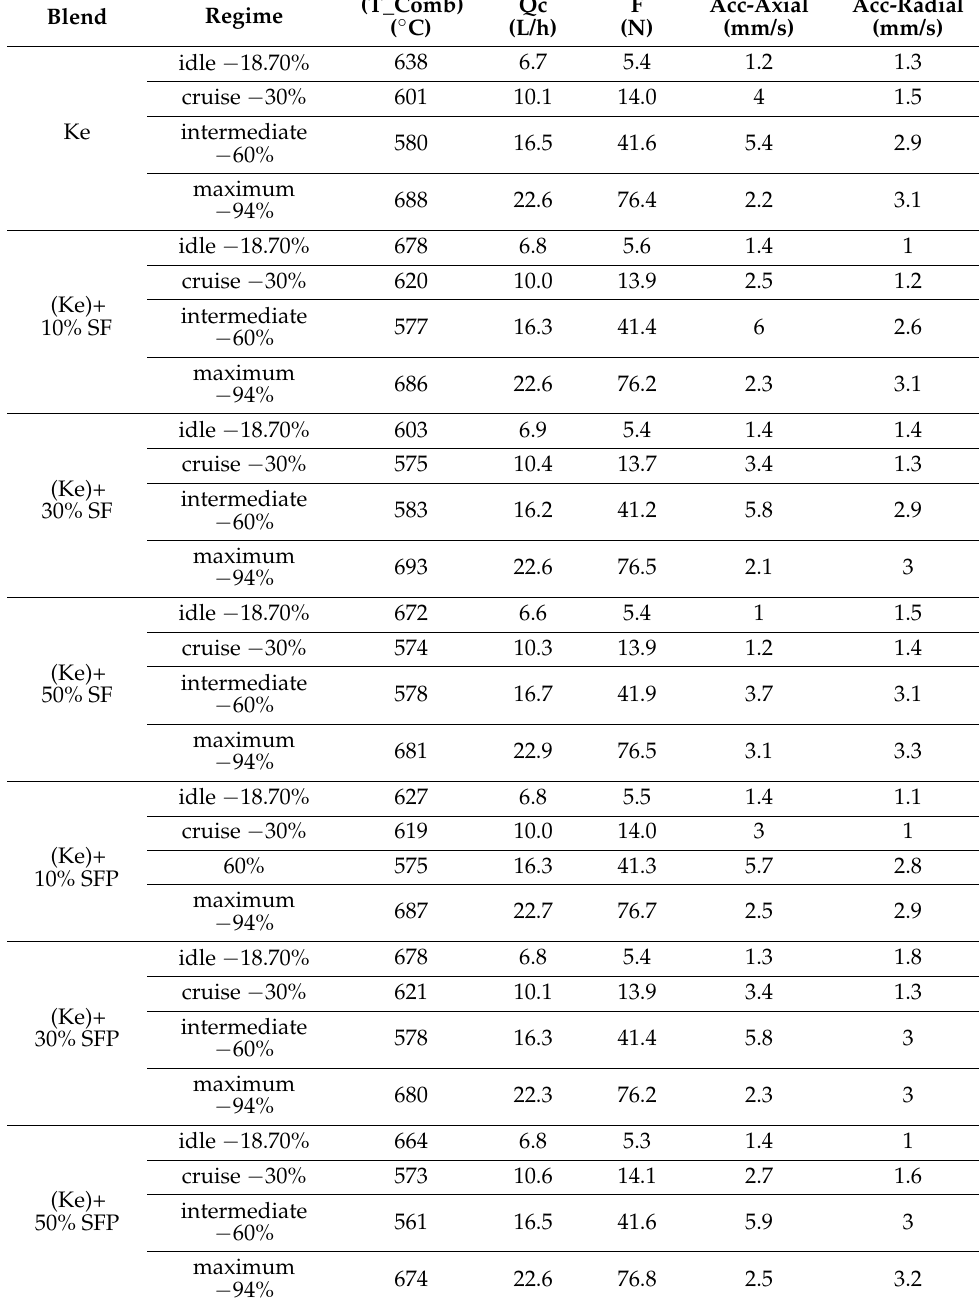
Table 2. Micro-turbo engine